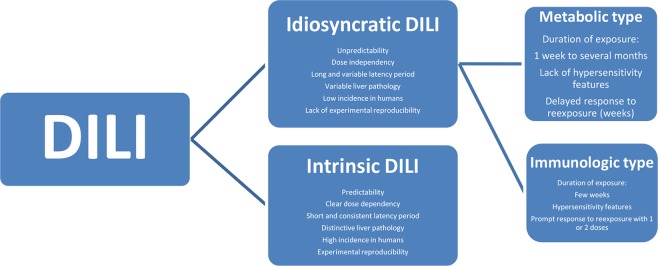
Characteristics of idiosyncratic DILI and intrinsic DILI. Reproduced from a previous report (Teschke and Danan, 2018b) with permission of the publisher Wiley-Blackwell Corporation. Abbreviation: DILI, drug-induced liver injury.